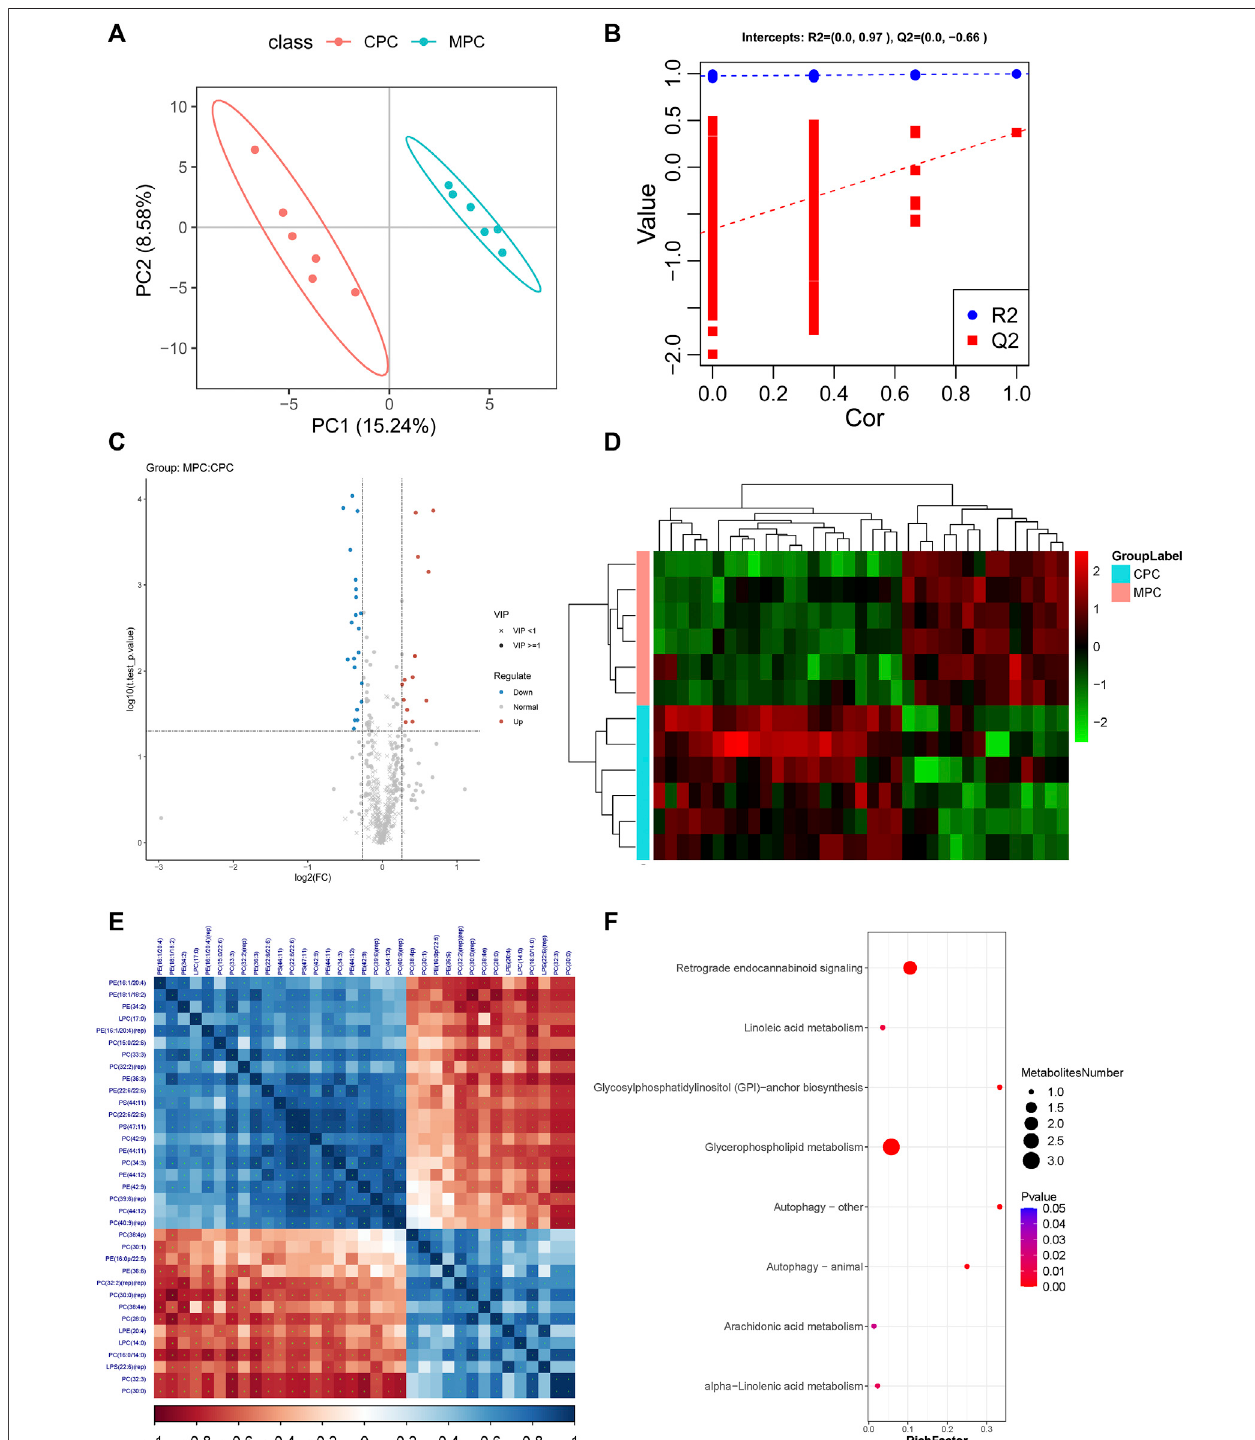
FIGURE 4 | Molecular analysis of differential lipids in the prefrontal cortex tissues of ApoE − / − mice fed a continuous high-fat diet combined with bound stimulation. CPC: Prefrontal cortex results ofNC group, MPC: Prefrontal cortex results ofHFB group. (A) Score plots for the PLS-DA discriminant analysis model ofdifferential lipids in prefrontal cortex tissue. The horizontal axis is the fi rst principal component and the vertical axis is the second principal component. Numbers in parentheses are the scores of that principal component, indicating the explanatory power of that principal component for the overall model. (B) Plots of response ranking tests for the PLS-DAanalysismodel ofdifferential lipidsinprefrontalcortex tissue.Thetworightmost points intheplot arethetrueR2Yand Q2valuesofthemodel, respectively,and